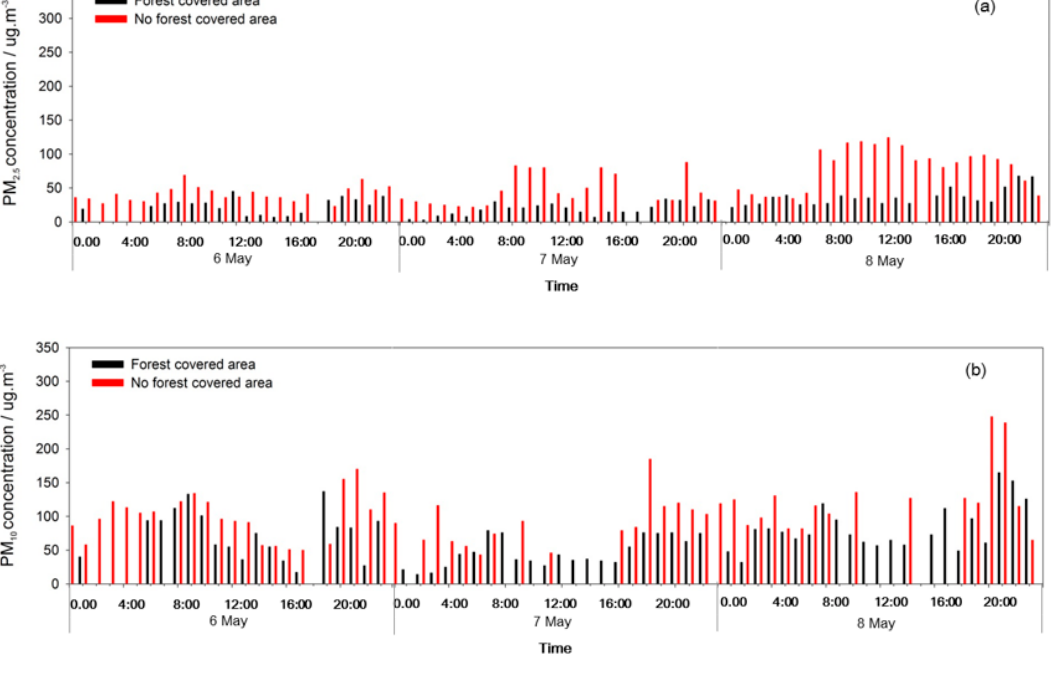
Figure 7. PM 2.5 ( a ) and PM 10 ( b ) concentrations changes in sunny days.